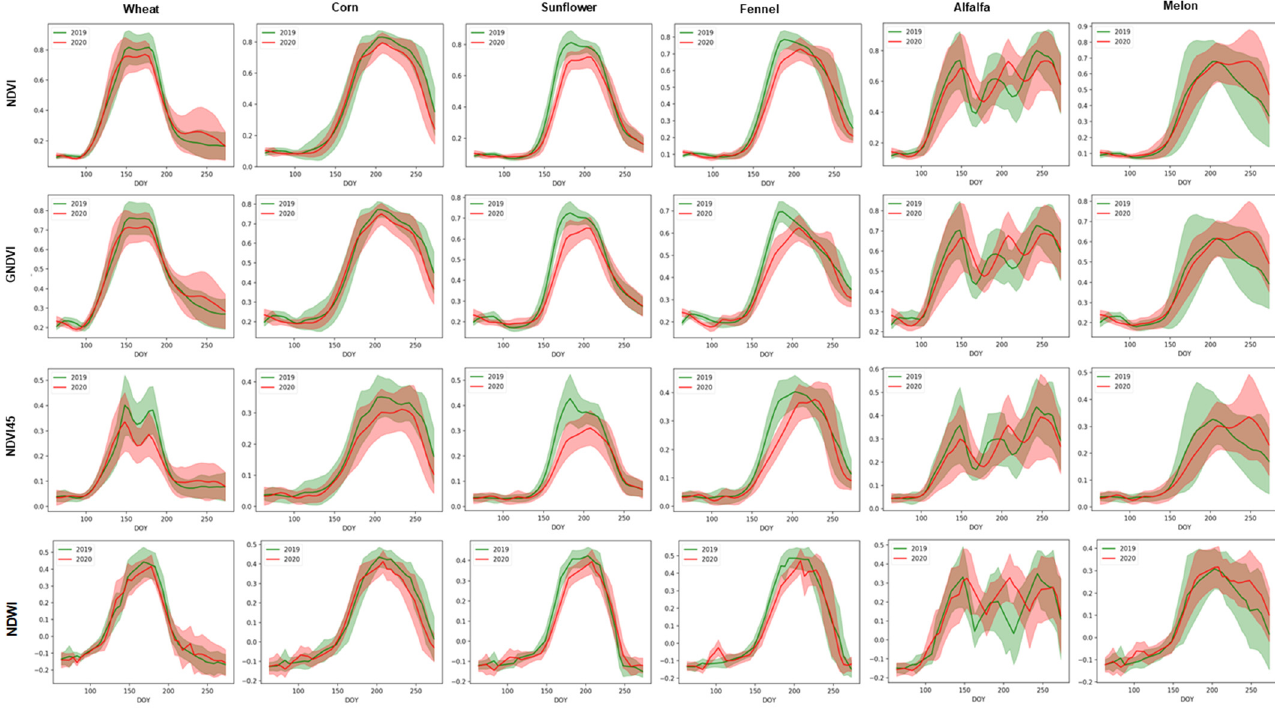
Figure 11. 5-day time series of the NDVI, GNDVI, NDVI45, and NDWI for the six main crops in 2019 and 2020. The mean value and error bars with one positive/negative standard deviation are shown. The green line is the time series data for 2019 and the red line is the data for 2020.